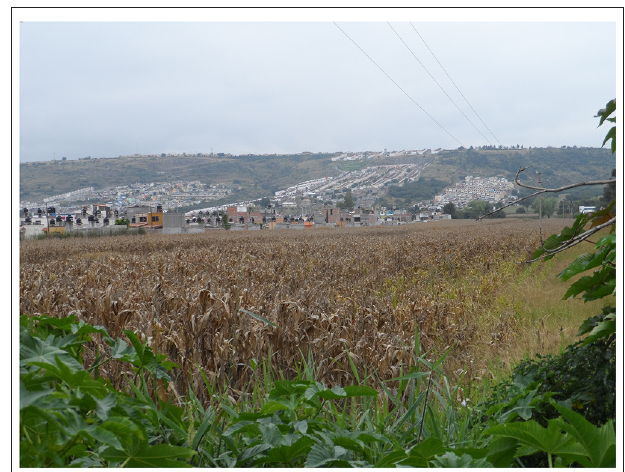
FIGURE 3 | Morelia-Tarímbaro conurbation